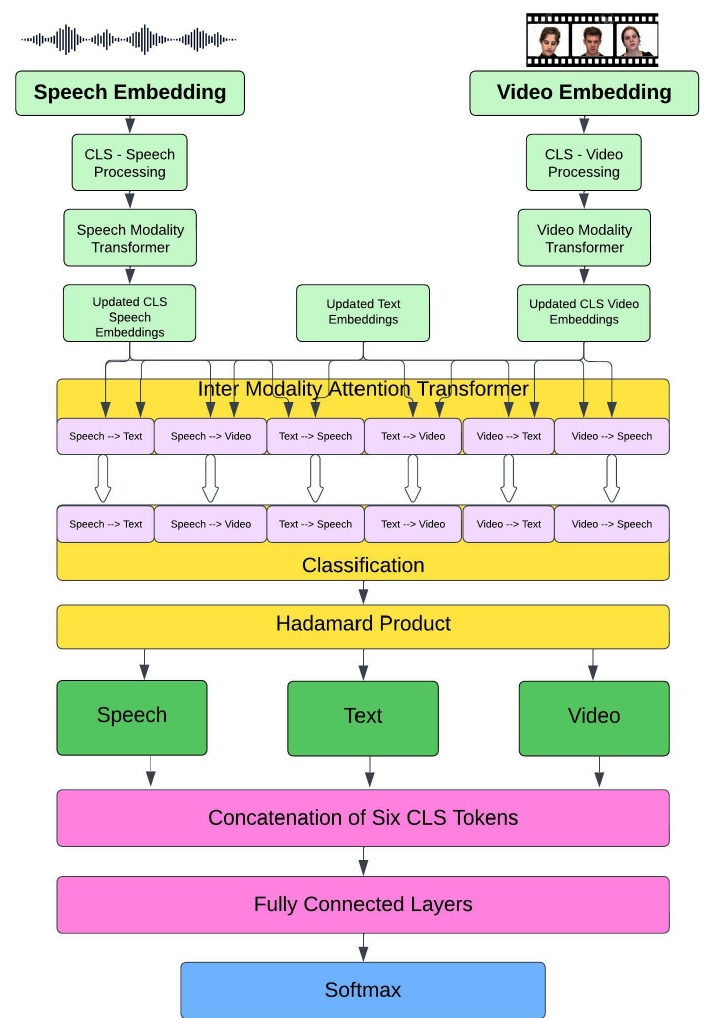
Figure 5 . Hadamard product voice and video embedding for emotion categorization from start to finish.